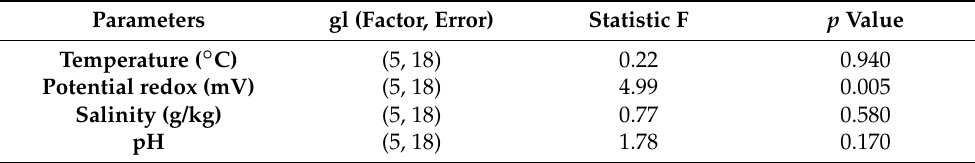
Table 2. ANOVA of a pathway of the physicochemical parameters of interstitial water in ponds during treatment with 2,4-D acid in seedlings of Rhizophora mangle ( p < 0.05).